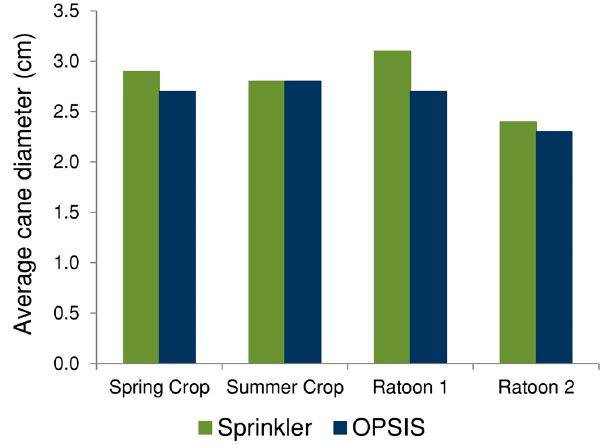
Figure 6. Average cane diameter of sugarcane cultivar Ni21 as affected by irrigation method.